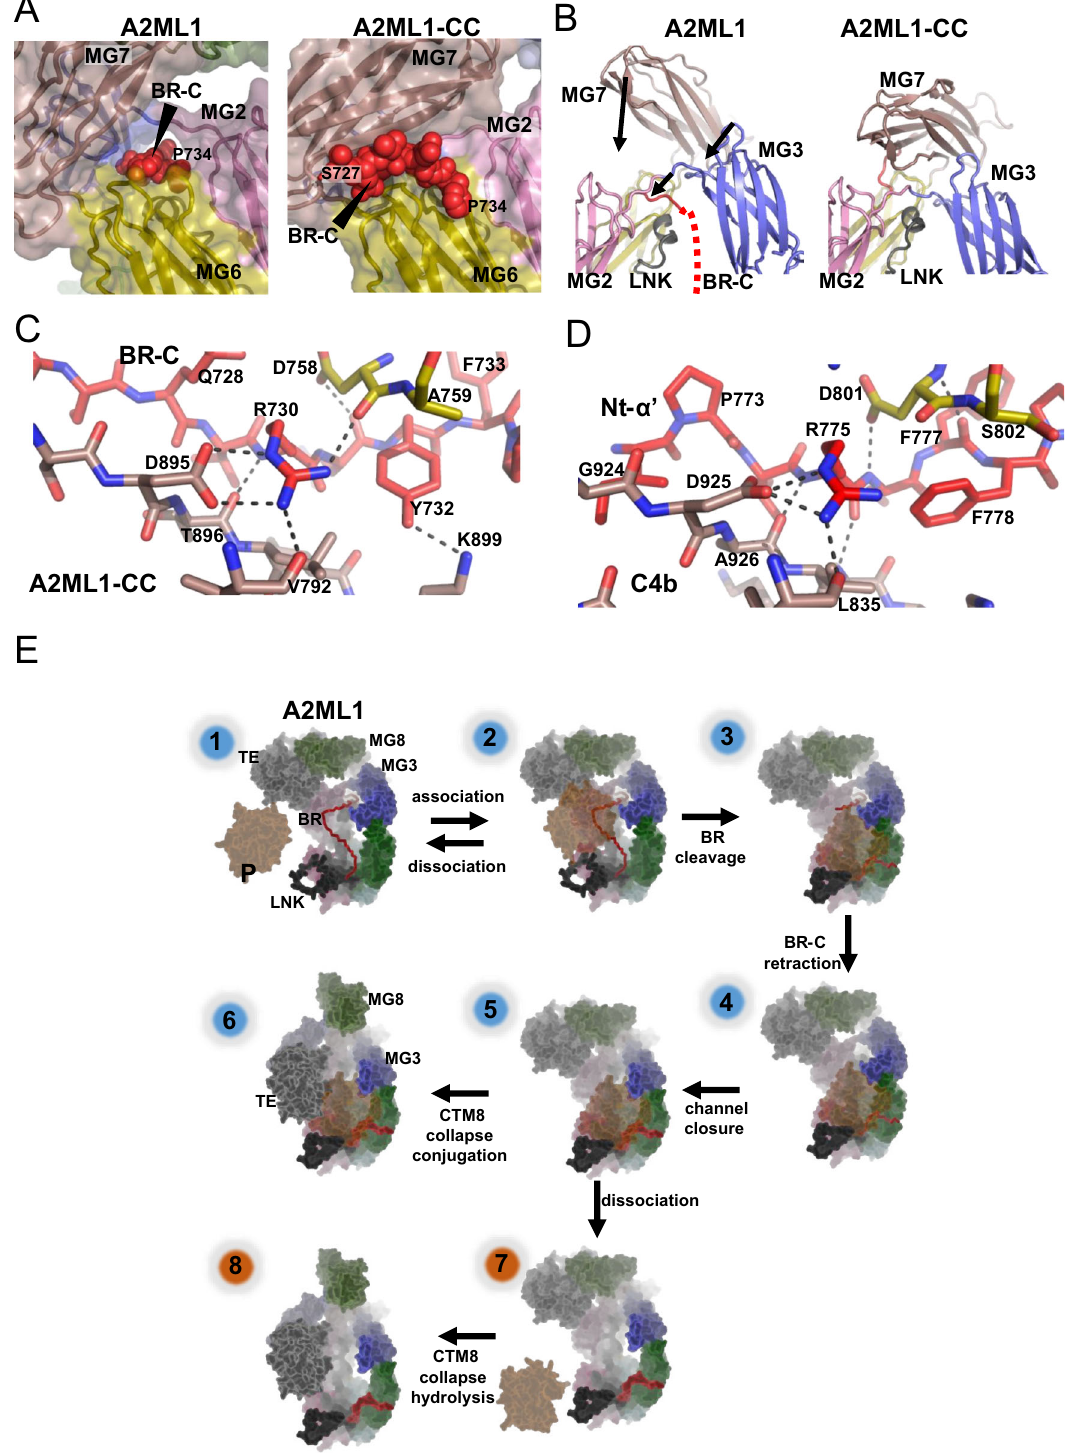
this case react with water (Fig. 7E, steps 7 – 8). We suggest that that these mechanistic steps are broadly conserved in A2MF